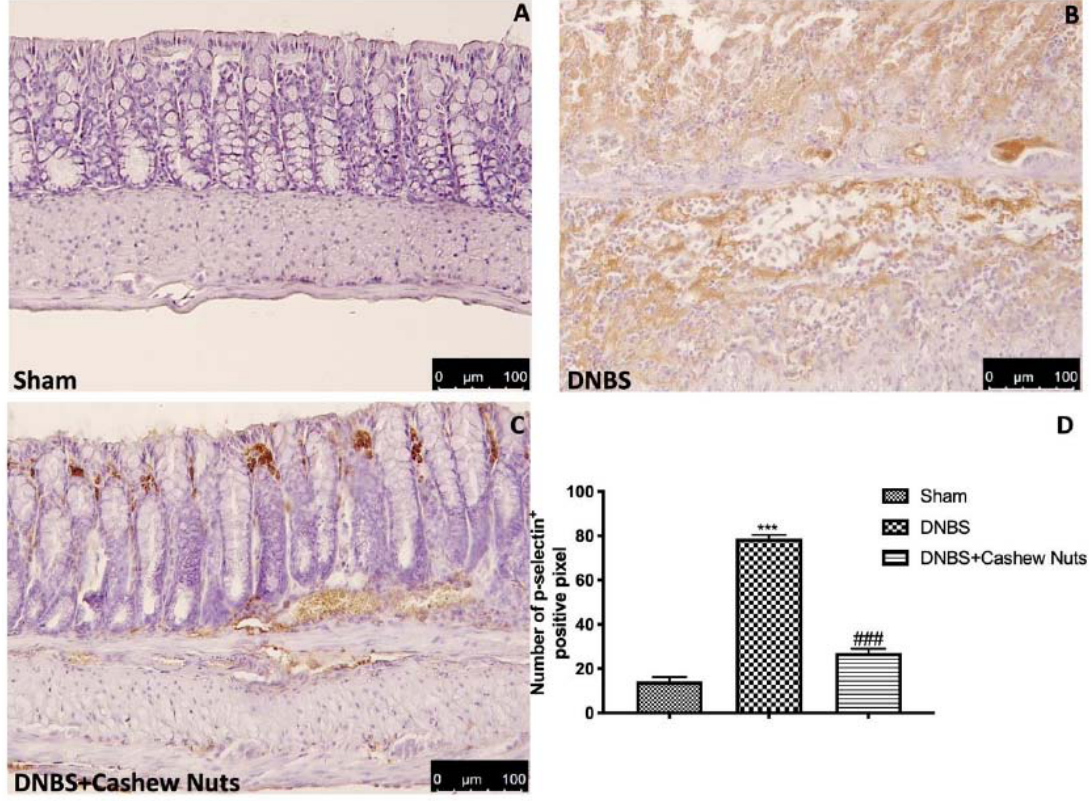
Figure 9. The e ff ects of cashew nuts on P-selectin expression after DNBS injection. Immunohistochemistry for P-selectin was evaluated in sham ( A ), DNBS ( B ), DNBS + cashew nuts ( C ). The results are expressed as % of positive pixels ( D ). Images are figurative of at least three independent experiments. Values = means ± SEM of six animals in each group; *** p < 0.001 vs. sham; ### p < 0.001 vs.